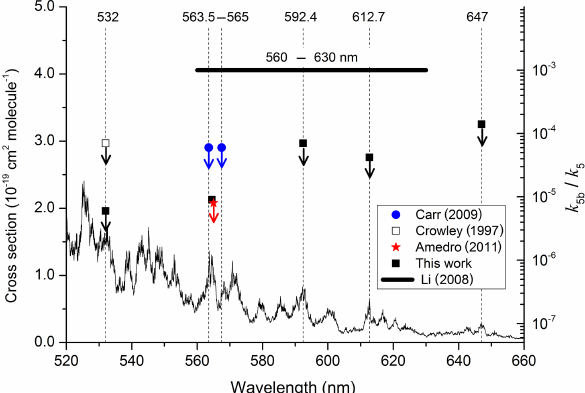
Figure 4. Summary of data obtained following photoexcitation of NO 2 at various wavelengths. The data from this study, Crowley and Carl (1997), Carr et al. (2009), and Amedro et al. (2011) are all up- per limits, indicated by the downward arrows. The NO 2 absorption cross sections were taken from Vandaele et al.